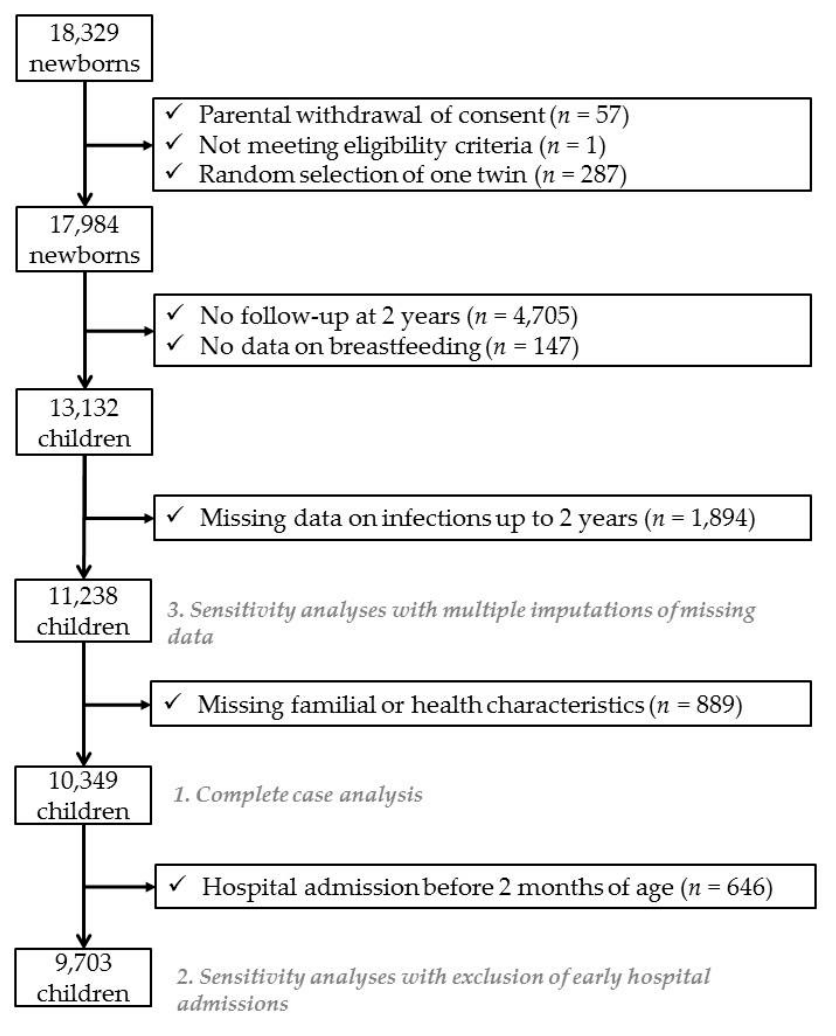
Figure 1. Sample